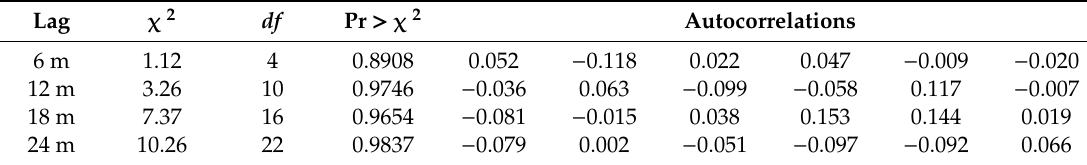
Table 4. Autocorrelations with